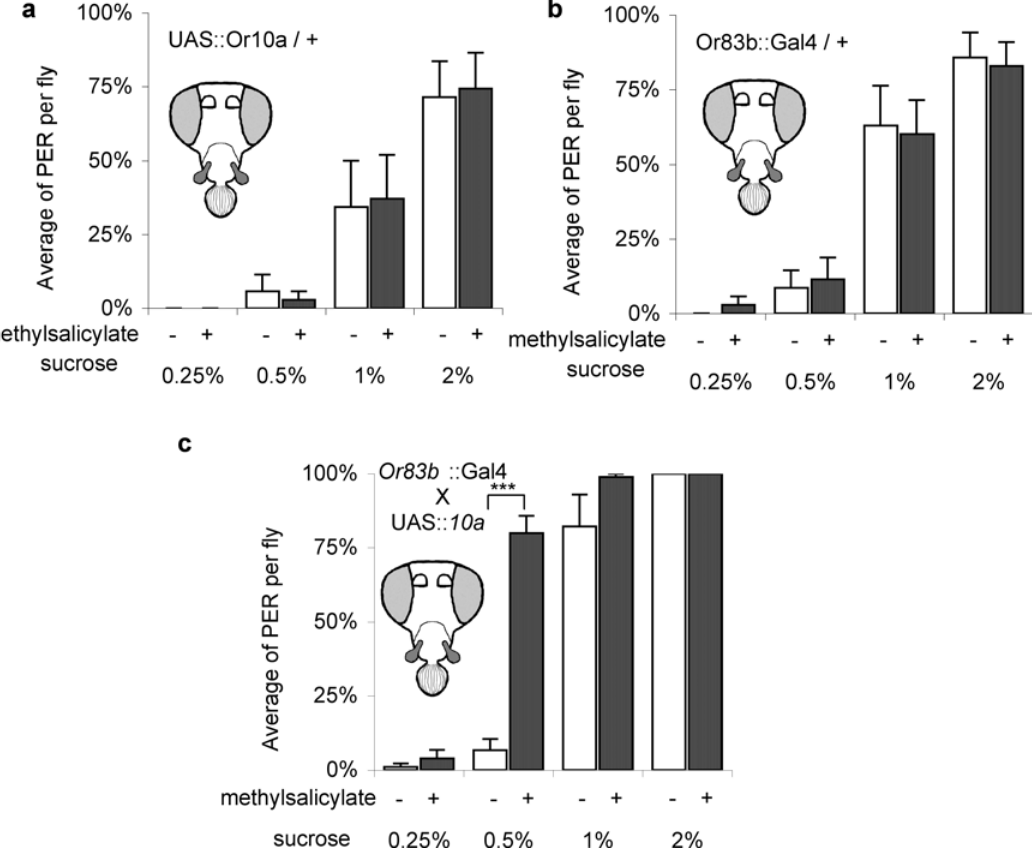
Figure 5. Introducing a foreign receptor in the maxillary palp. Effect of methyl salicylate on taste enhancement in a) UAS::Or10a / + , b) Or83b::Gal 4 / + line and c) the offspring from the cross UAS::Or10a 6 Or83b::Gal4 . The threshold for sucrose was different in the three lines. But the significant point was still at the sub-threshold concentration. Ant 2 , MP + flies were used in all experiments. n=7 to 14